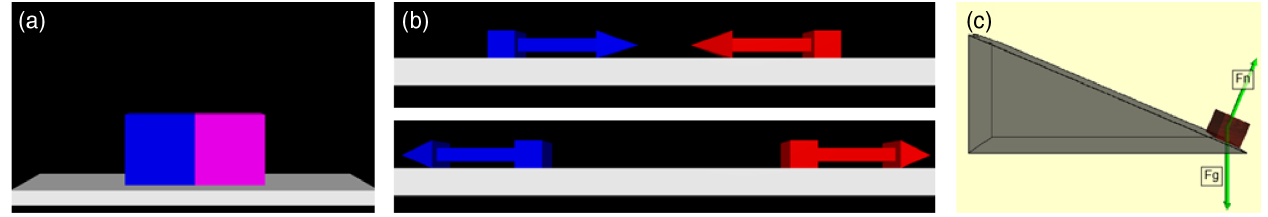
FIG. 10. Outputs displayed in Liam ’ s solutions for computational models of (a) colliding crates, (b) momentum conservation (top panel for before the collision and bottom panel for after the collision), and (c) block on a ramp